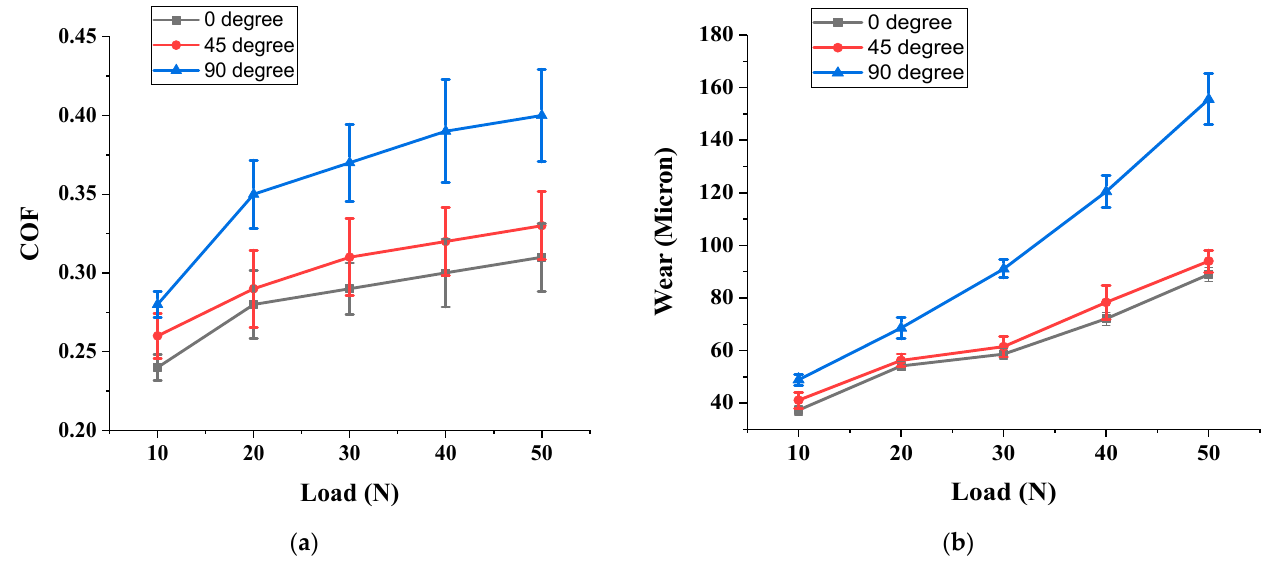
Figure 4. ( a ) Wear vs. load for different fiber orientations; ( b ) COF vs. load for different fiber orientations.